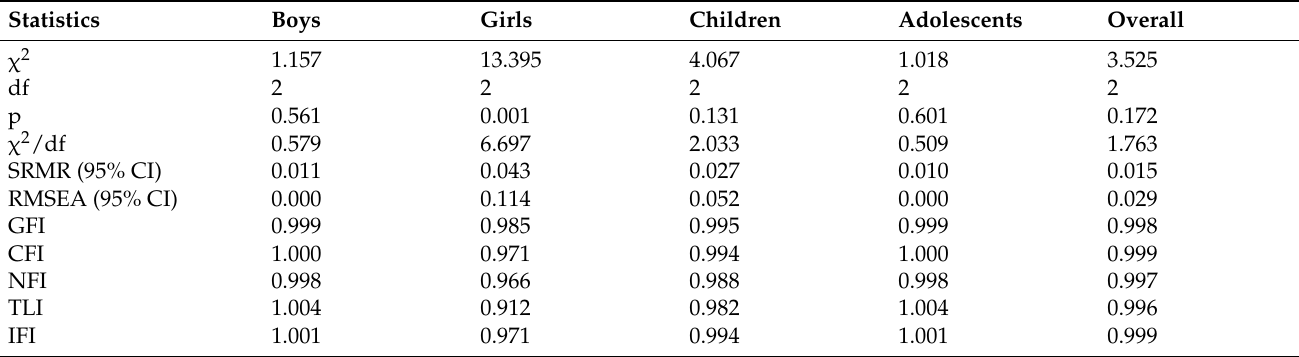
Table 4. Goodness-of-fit indices for the IFIS-C in Chinese children and adolescents.